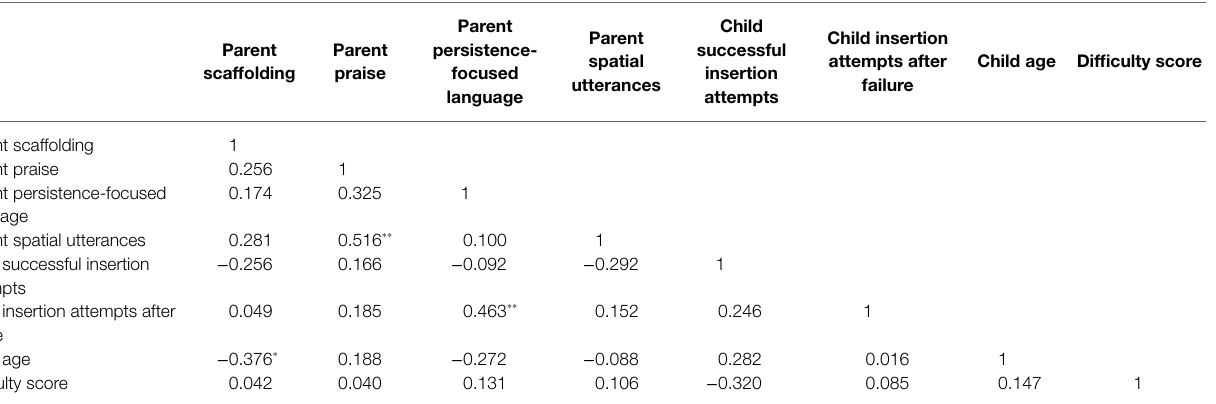
TABLE 1 | Correlation between variables.